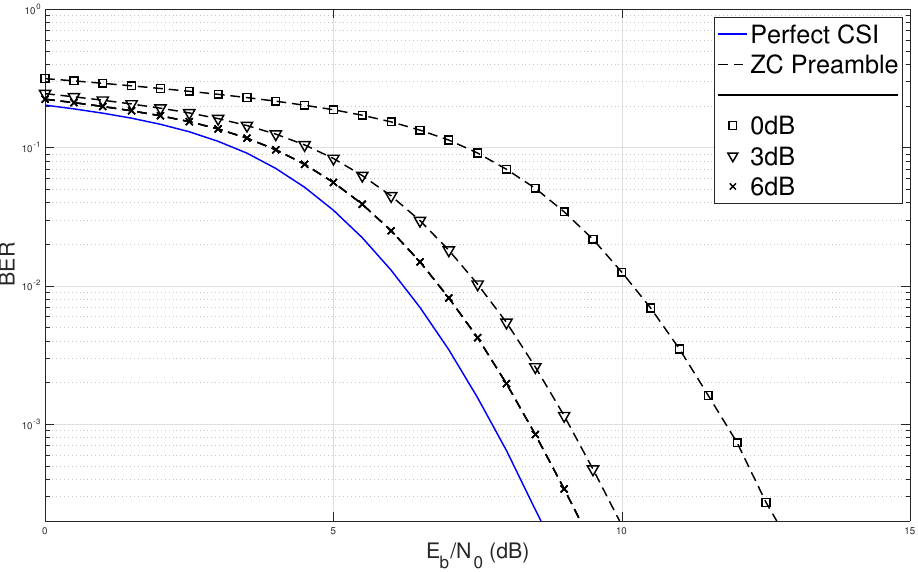
Figure 5. BER results for TIBWB–OFDM over a dispersive channel employing Algorithm A for a ZC preamble sequence with power